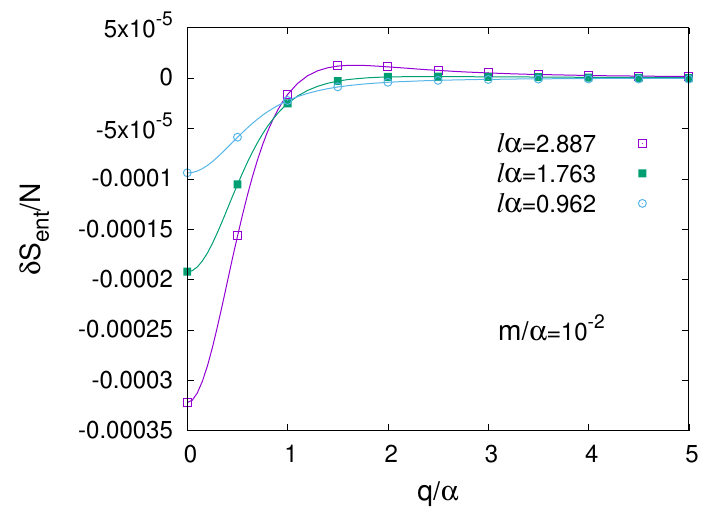
Figure 1 . Entanglement entropy change per fermion due to a mass deformation for intervals of different lengths, as a function of the superflow momentum q (in units of α = 2 πT ). Curves: results of a holographic calculation using general relativity as the dual. Points: results of a direct calculation in lattice field theory. The interval lengths are the same as in table